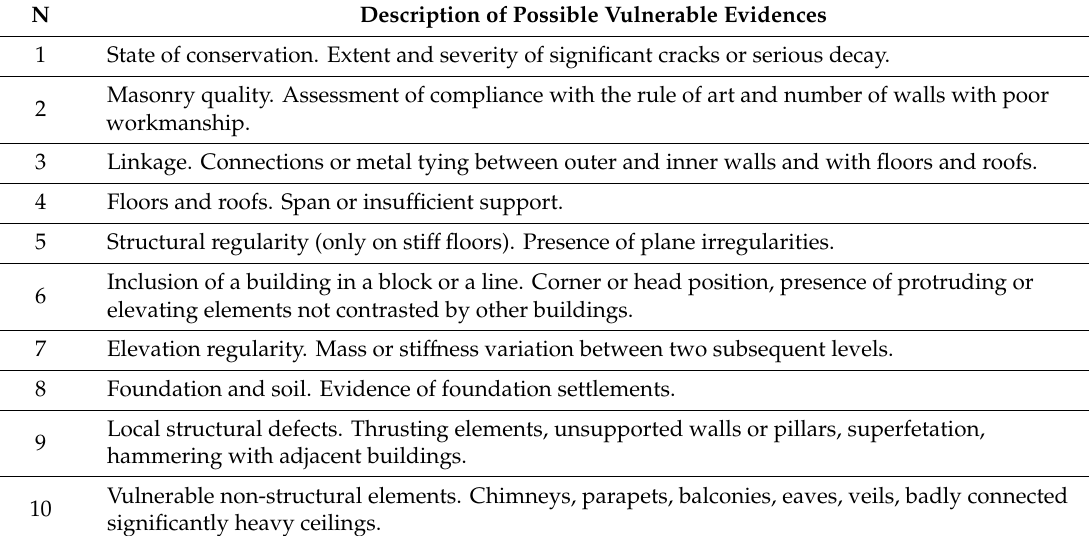
Table 2. C / Q Classification / Quantification) seismic method; structural deficiencies to be considered for